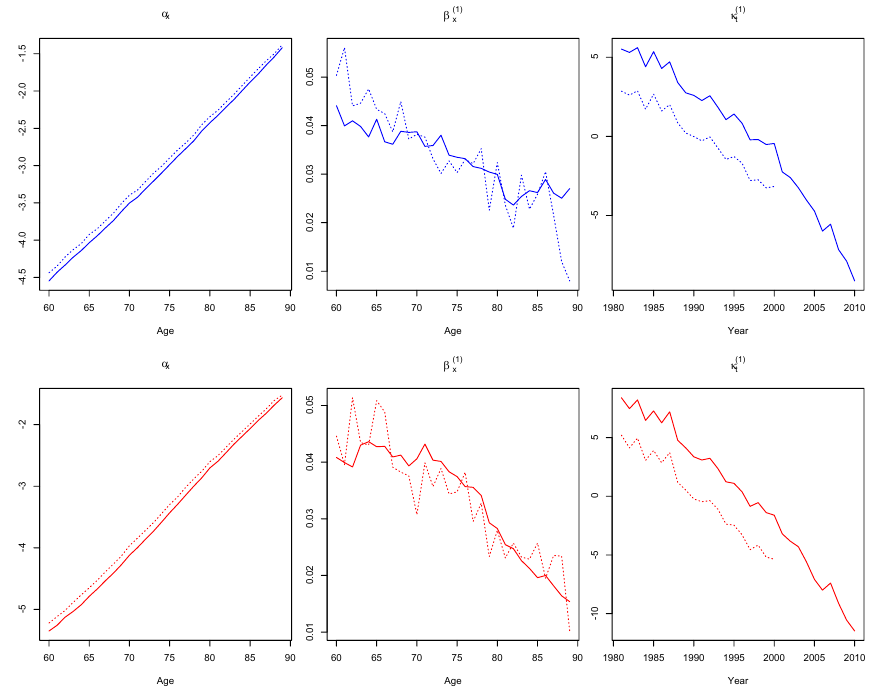
( 1 ) ( 1 ) Figure 1. M 1 : α x , β estimated parameters for males ( top panels) and females ( bottom x and κ t panels), aged 60–89, fitted in 1981–2010 (solid lines) and 1981–2000 (dotted lines).